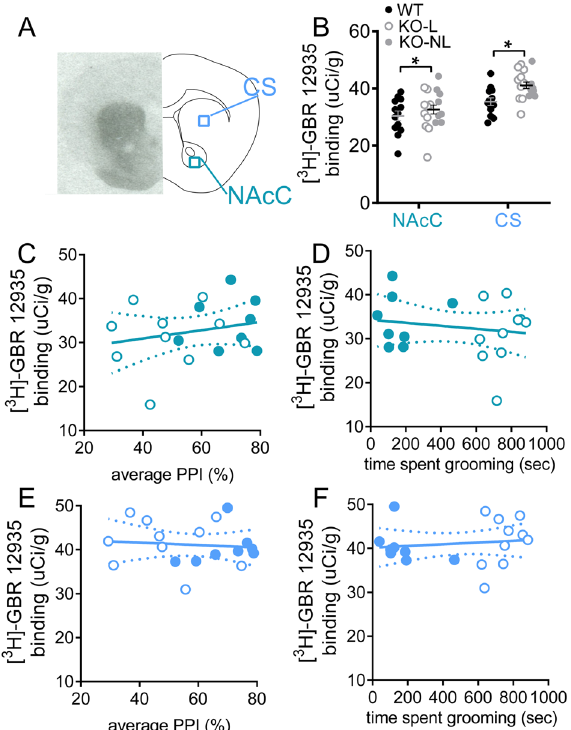
Figure 4. DAT binding in striatum is increased in Sapap3-KOs. ( A ) Autoradiography was performed in striatal tissue to quantify density of DAT in CS and NAcC using [ 3 H]-GBR-12935. Representative autoradiograph for total binding is shown in the left panel, with schematic of coronal brain section on the right. ( B ) DAT density was elevated in Sapap3-KOs. DAT binding in NACc was not correlated with disruption of PPI ( C ) or grooming severity ( D ) in Sapap3-KOs. DAT binding in CS showed no association with PPI ( E ) or grooming ( F ) in Sapap3- KOs. In panel ( B ), * indicates significant difference between WT and KO (p < 0.05). In panels ( B – F ), unfilled KO symbol indicates KO-L, filled KO symbol indicates KO-NL. n = 13 WT, 18 KO. PPI prepulse inhibition, CS central striatum, NAcC Nucleus accumbens core, DAT dopamine transporter, KO Sapap3 knockout, KO-L KOs with lesions, KO-NL KOs without lesions, WT